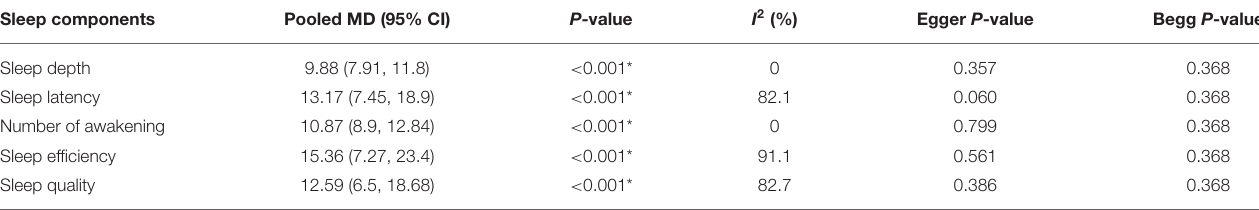
TABLE 3 | Efficacy of eye masks and/or earplugs interventions for sleep components based on RCSQ. Sleep